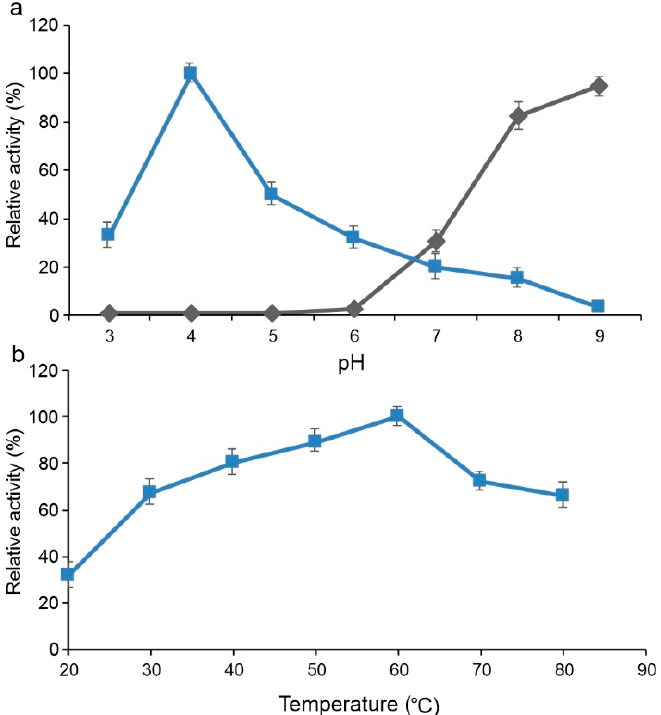
Figure 5. pH and temperature optimum of the recombinant Sbv286-LAC. Relative laccase activity at